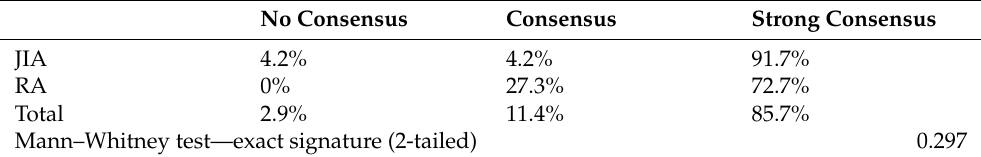
Table 9. Strength of consensus.